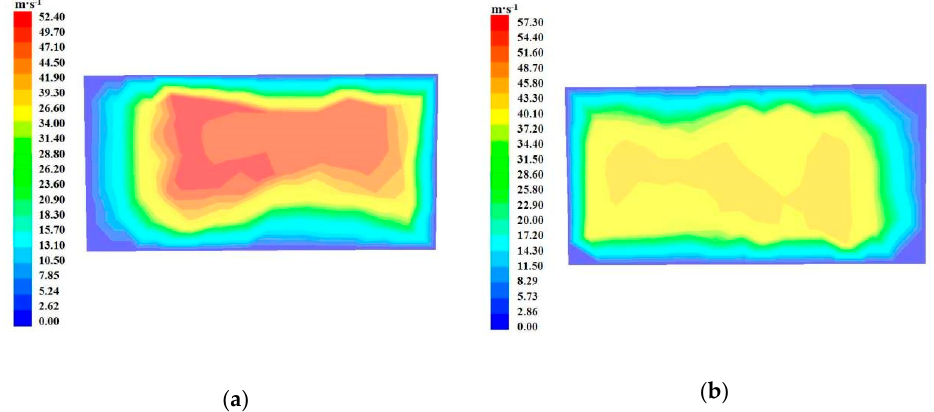
Figure 4. Velocity cloud without area reduction outlet: ( a ) outlet in the lower part; ( b ) outlet on the symmetric plane.